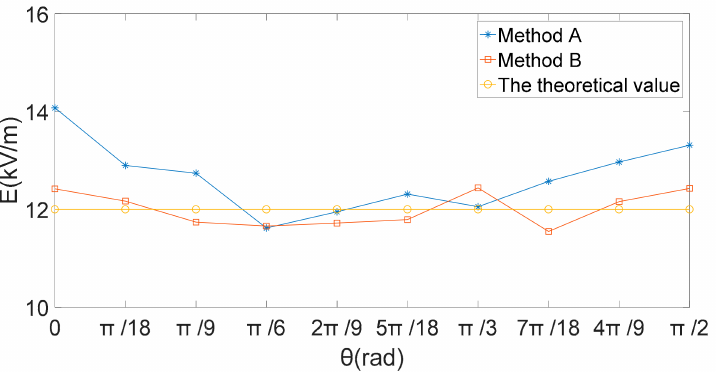
Figure 10. Electric field intensity (E/(kV/m)).